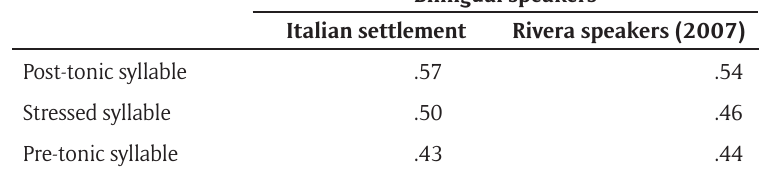
Table 12: Comparison of palatalization of dental stops according to syllable stress among bilingual group (Bisol, 1991) and Rivera speakers (2007